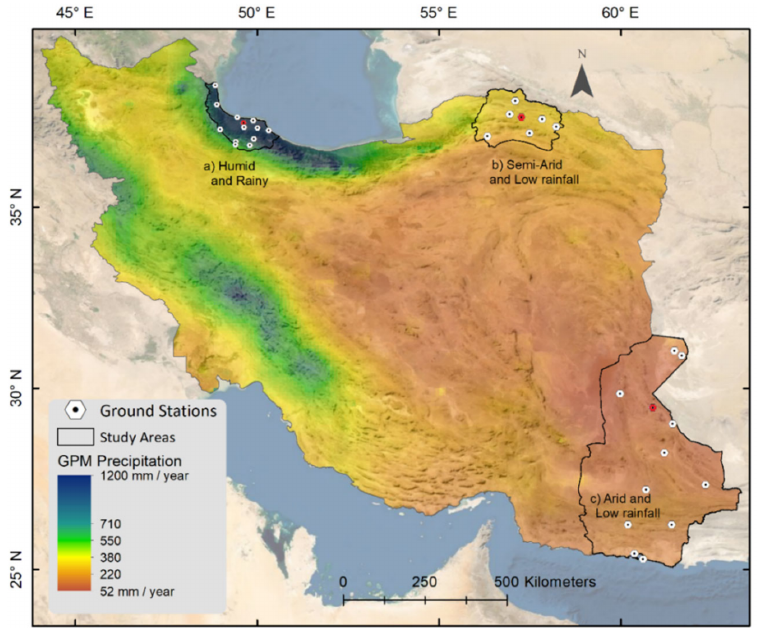
Figure 1. Distribution of annual average precipitation (GPM/IMERG) over the study areas in the year 2017: ( a ) Gilan (humid and rainy), ( b ) North-Khorasan (semi-arid and low rainfall), ( c ) Sistan- Baluchestan (arid and low